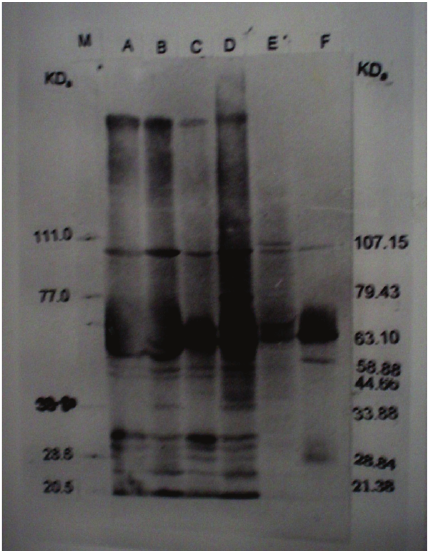
Figure 3: Immunoblot analysis of whole cell and sonicated super- natant antigens against M. agalactiae RPNS 216 hyperimmune sera. Lane A: WCA of M. agalactiae RPNS 216. Lane B: WCA of M. agalactiae RPNS 210. Lane C: SSA of M. agalactiae RPNS 216. Lane D: SSA of M. agalactiae RPNS 210. Lane E: SSA of M. bovis NC 317. Lane F: WCA of M. bovis NC 317. Lane M: Molecular weight marker.